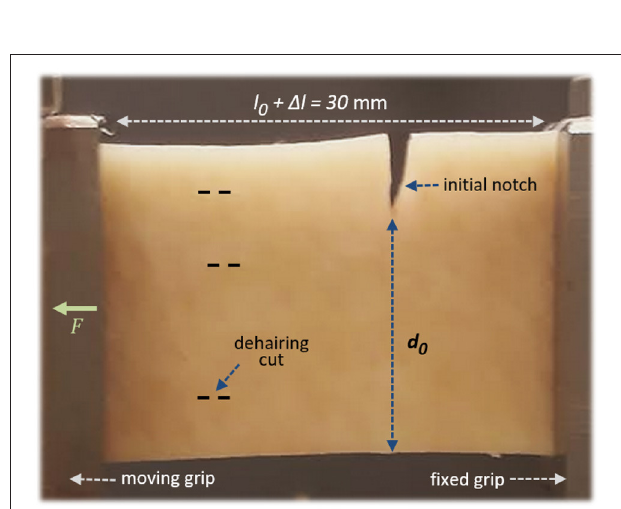
FIGURE 2 | A porcine skin sample installed in the set-up, with the epidermis facing the camera. A little stretch, 5%, is here applied by the force F , so that ∼ the nominal sample length between the grips is l 0 28.5mm and the stretch = is 1 l 1.5mm. The initial unbroken width is denoted d 0 . The dashed lines = illustrate some barely visible (shallow) cuts on the epidermis, from the dehairing process. The picture’s point of view corresponds approximately to that of the infrared camera during the